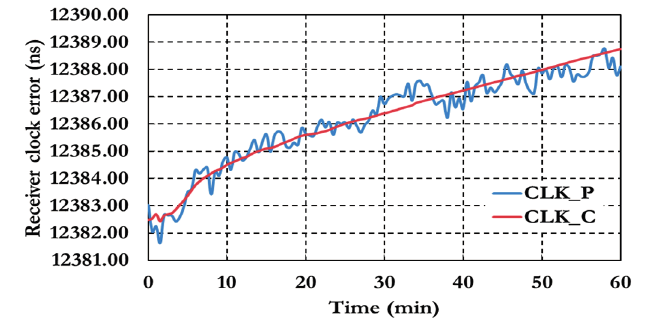
Figure 13. Receiver clock errors of the semi-decoupled clock GPS/Galileo PPP model.